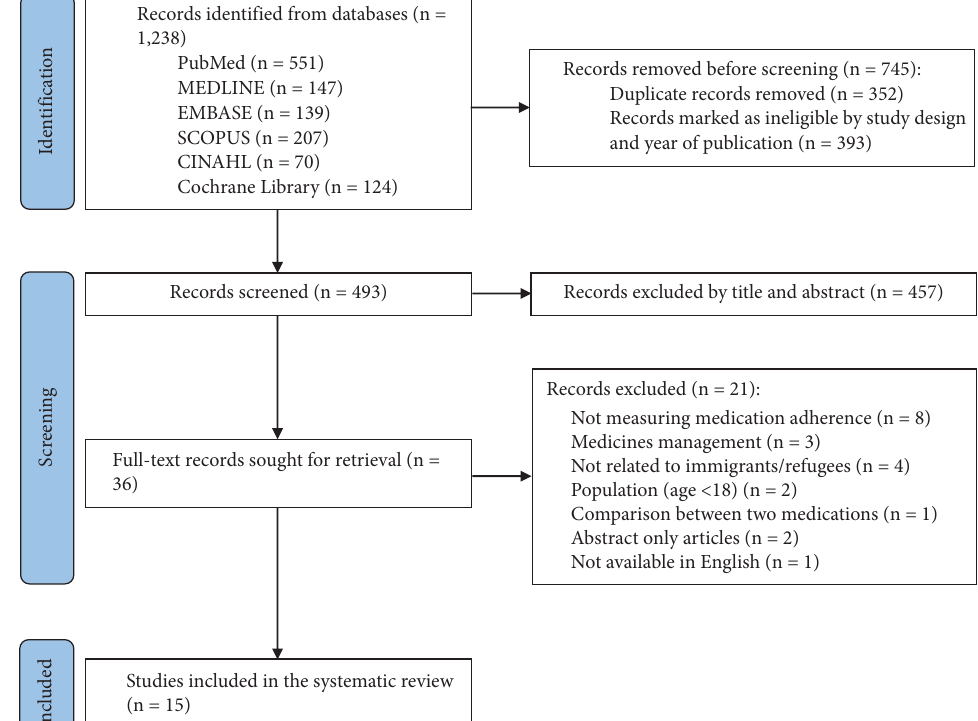
Figure 1: PRISMA fow diagram of the selection